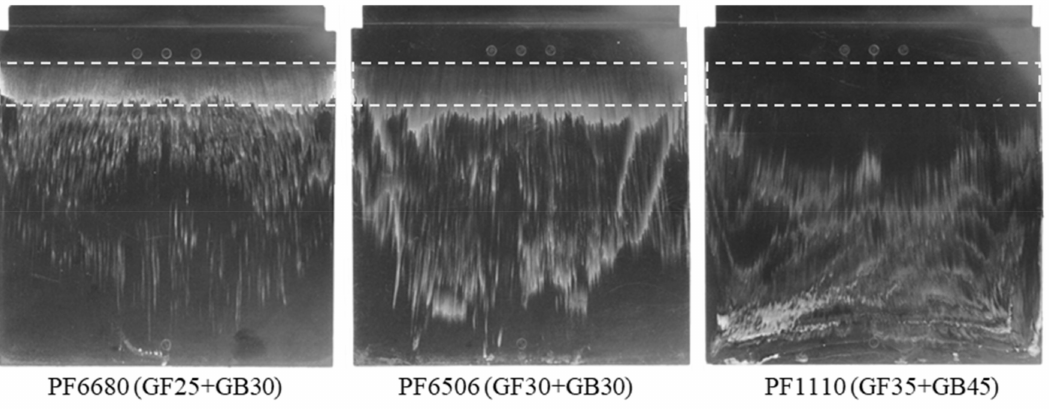
Figure 5. Influence of filler content on the slip